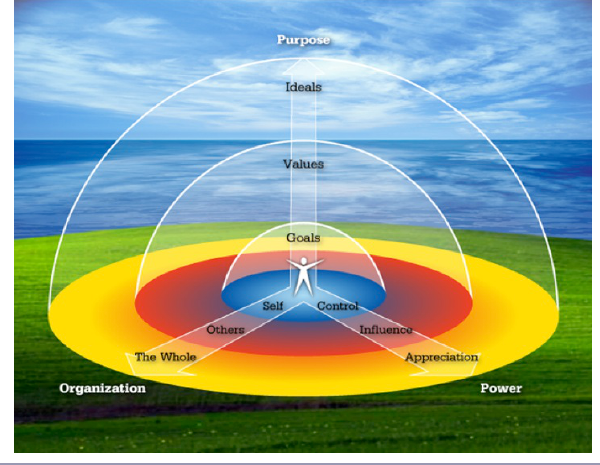
Fig. 1 . The Appreciation-Influence-Control model: an